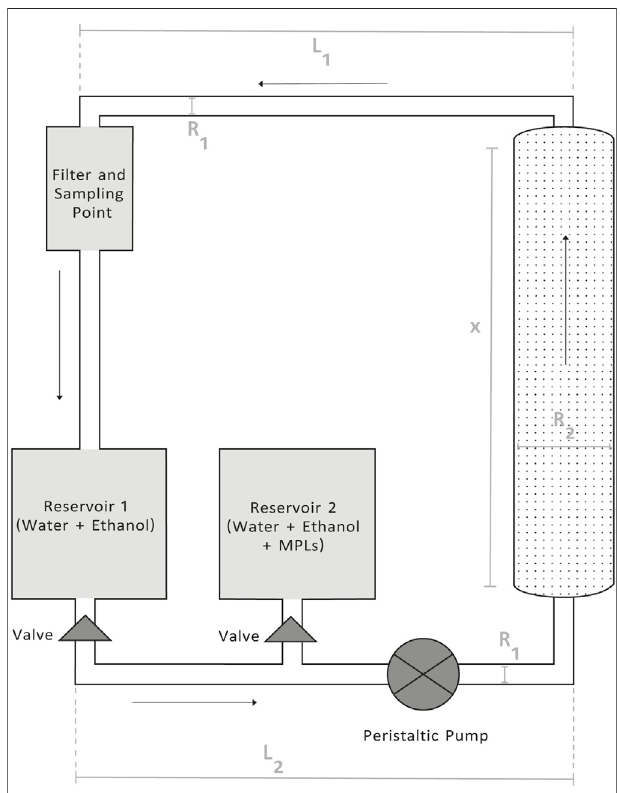
FIGURE 5 | Experimental setup for the microplastic tests.